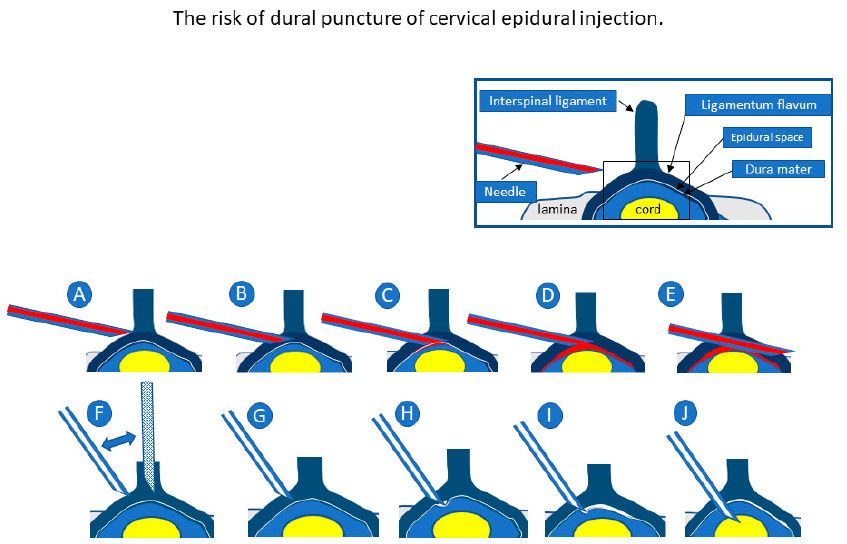
Figure 7. Upper figures show our cervical epidural injection (CEDI) method in which the needle is inserted tangentially into the dura ( A ‒ E ). Lower figures show the conventional CEDI method wherein the needle is inserted nearly perpendicular to the dura ( F ‒ J ). In both methods, loss of re- sistance may be confirmed before and after the insertion into the flavum ( A , C , F , H ). The closer the needle is inserted vertically, the higher the risk of dural puncture because the safety margin between the flavum and the dura becomes narrower ( G , H ). The risk of dural puncture can be avoided if the